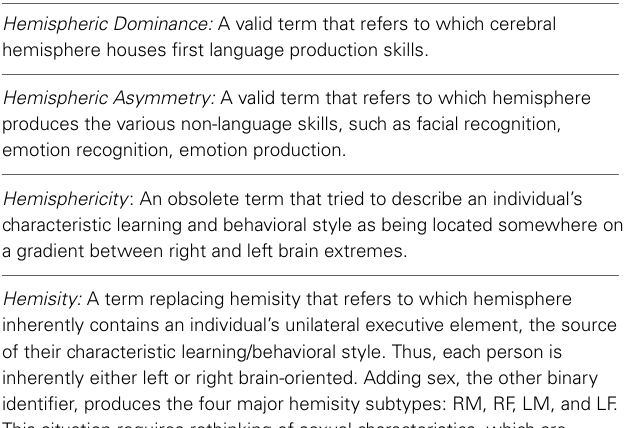
Table 1 | Three essential cerebral hemisphere laterality terms.